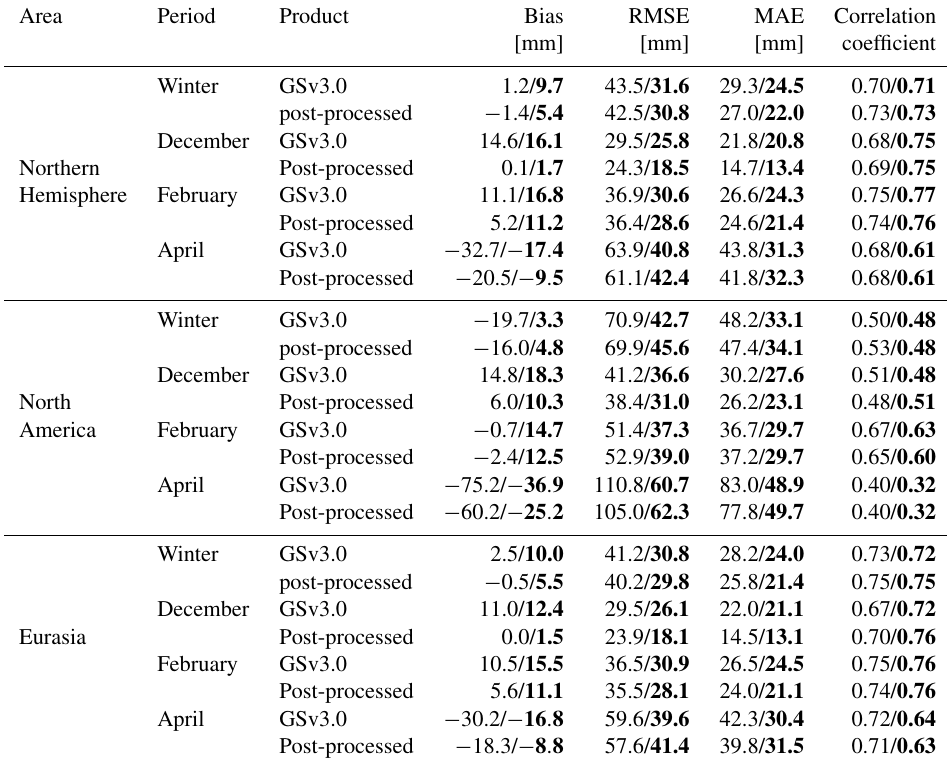
Table 3. Results of validation for the whole Northern Hemisphere, Eurasia, and North America for the whole winter, February, April, and December for 1979–2018. Left values are for SWE < 500mm and bold values are for SWE <